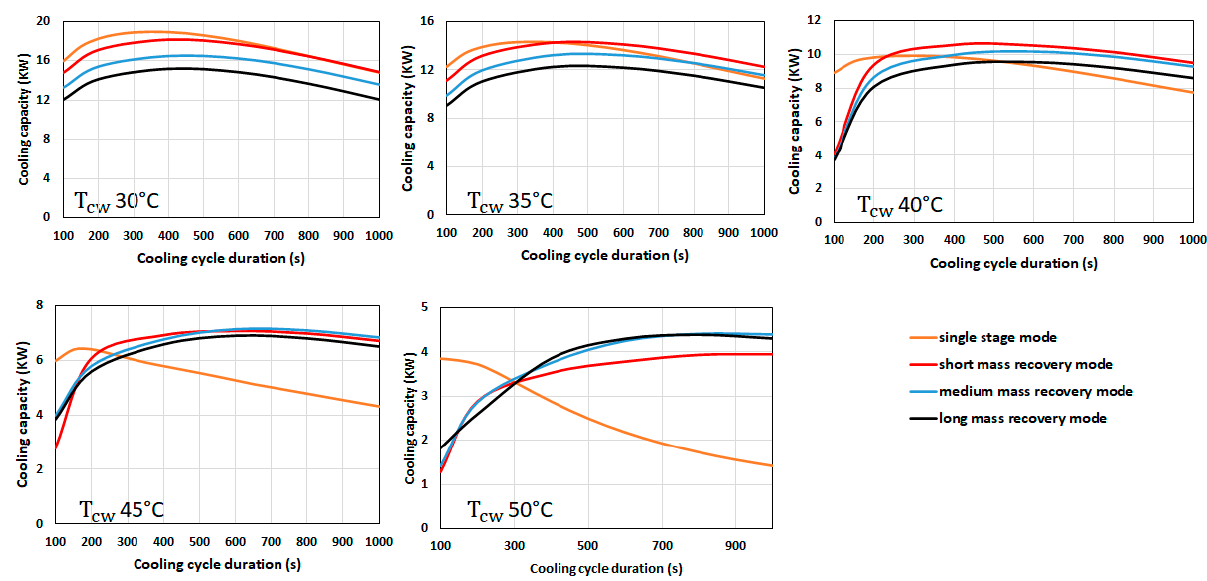
Figure 17. Predicted cooling capacity at various cycle modes and recooling water temperatures.